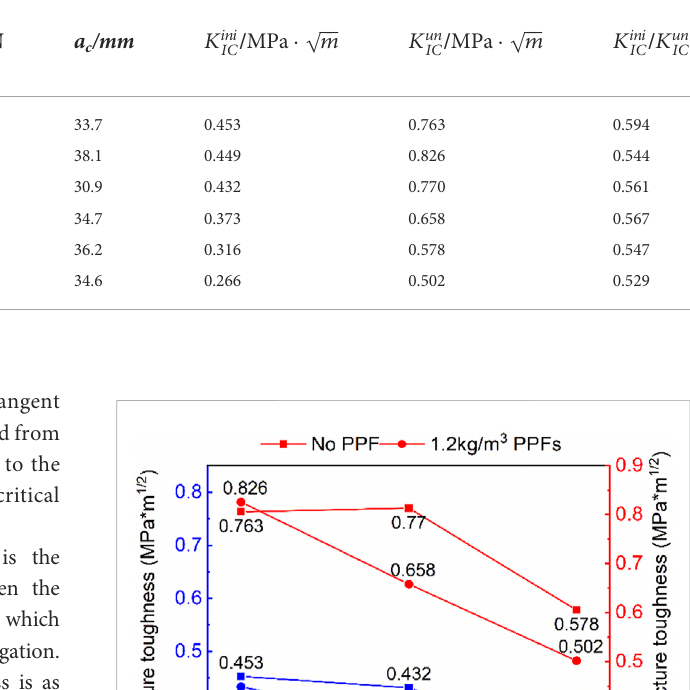
TABLE 5 Double-K fracture parameters.